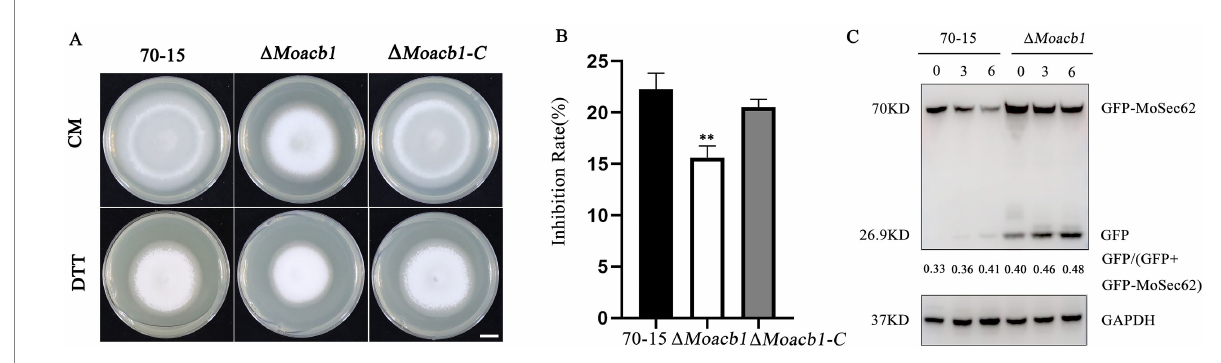
FIGURE 7 MoAcb1 participated in the analysis of ER autophagy. (A) The 70-15, ∆ Moacb1 and ∆ Moacb1-C strains were inoculated on CM plates containing 2 mM DTT at 25 ° C for 8 days. Bar, 1 cm. (B) Relative inhibition rate of the 70-15, the ∆ Moacb1 and ∆ Moacb1-C strains on CM medium containing 2 mM DTT, with the standard deviation indicated by error bars. T -test was used to test for significant differences. ** p < 0.01. (C) Immunoblot analysis of MoSec62- GFP proteolysis in the 70-15 and ∆ Moacb1 mutant